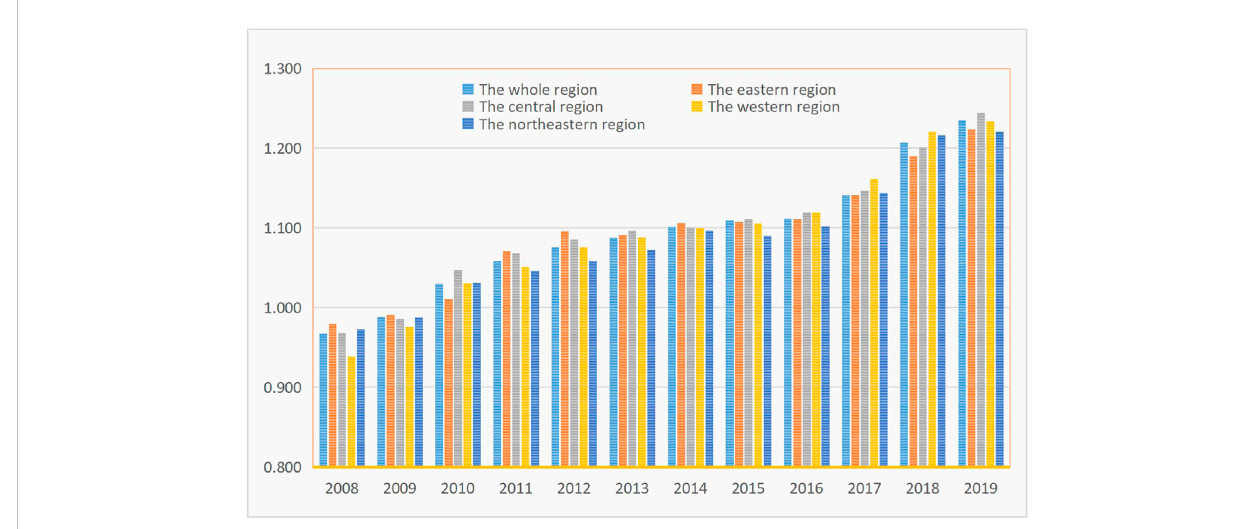
FIGURE 2 Development trend of AGTFP in China from 2008 to 2019.